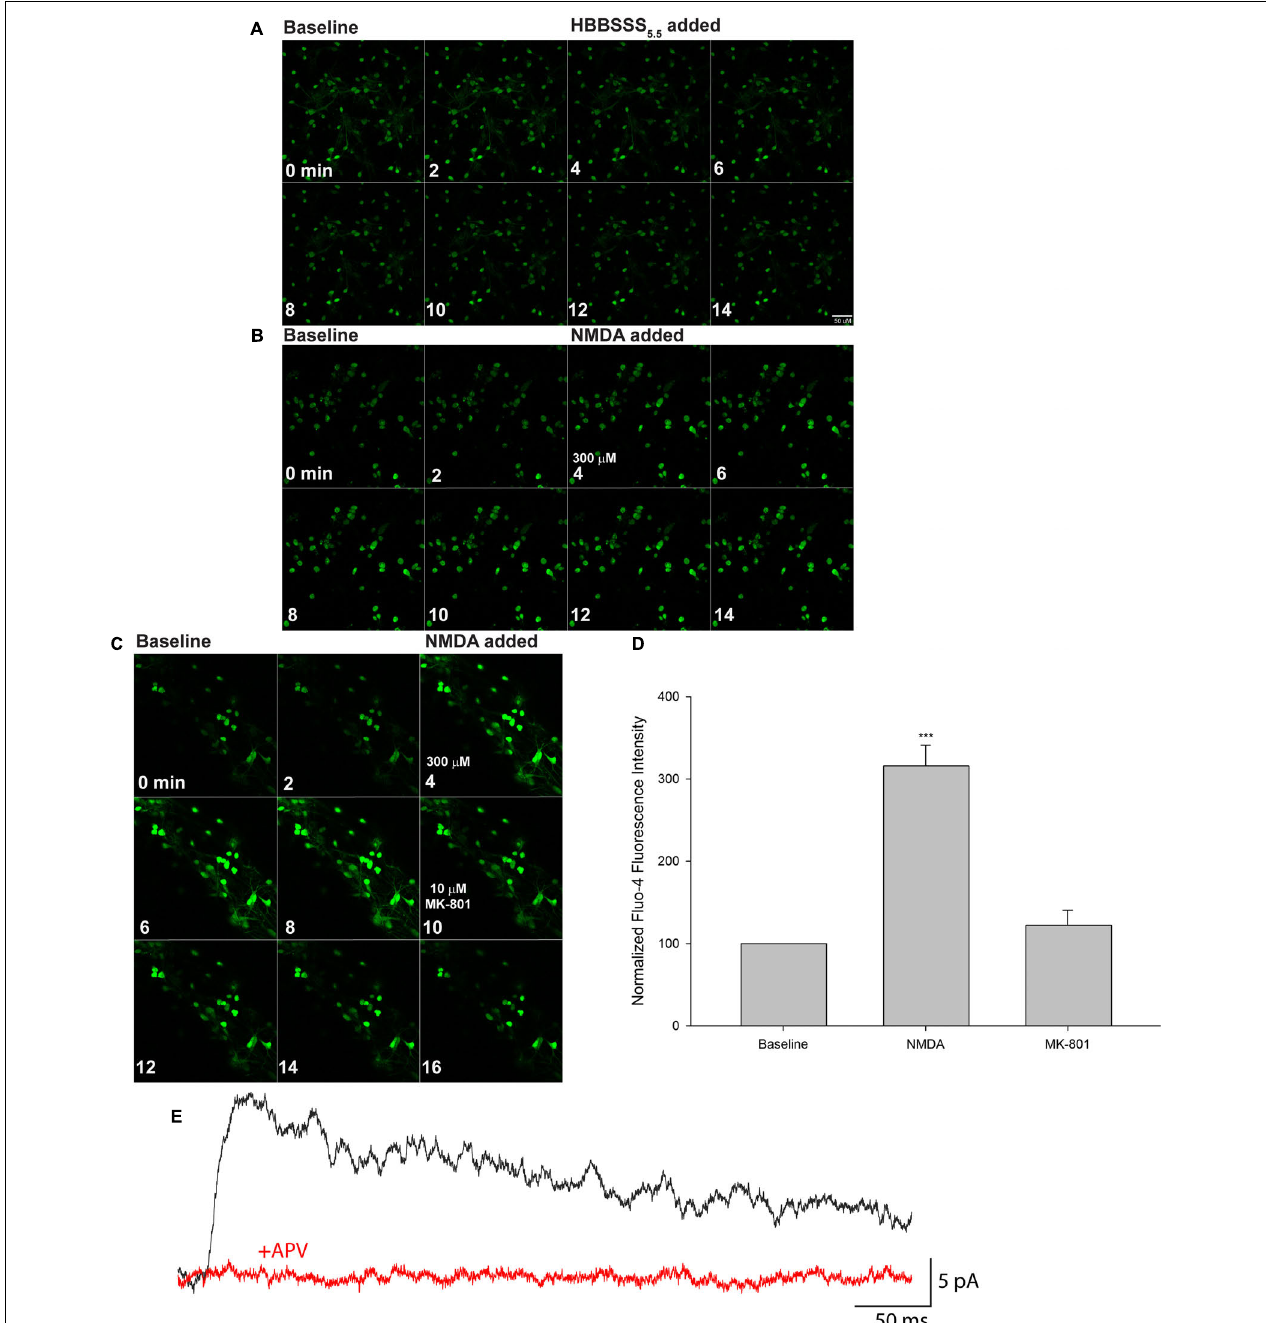
FIGURE 4 | Mature iPSC-derived neuronal cultures express functional NMDA receptors (NMDARs). XCL-4 derived mature cultures (30–39 days in maturation media) were loaded with the calcium indicator Fluo-4 for 30 min and then washed with HBBSS 5 . 5 media, followed by the addition of glycine (final concentration of 100 µ M) prior to imaging. Using a time series protocol at 40 × magnification, two baseline images were taken prior to the addition of vehicle (HBBSS 5 . 5 ), or a final concentration of 300 µ M NMDA. For some cultures, the NMDAR antagonist MK-801 at a final concentration of 10 µ M was added after additional images were taken. (A–C) Representative montages are shown. Fluo-4 time series images were analyzed using MetaMorph. Individual cells were identified and Fluo-4 fluorescence intensity at each time point was measured. The intensity of cells at each time point were averaged together. The first two time points were averaged as the baseline intensity, and all data were normalized to the corresponding baseline. (D) Data from the montage shown in panel (C) were graphed using SigmaPlot 14.5. One-way repeated measures ANOVA and Bonferroni tests were performed using SigmaPlot 14.5. Data are represented as mean + SEM. *** P < 0.001. n = 21 cells per condition. (E) A representative trace is shown of an NMDAR-mediated electrically evoked postsynaptic current from XCL-4 derived mature cells in the presence of the GABA A receptor antagonist, picrotoxin (final concentration: 50 µ M), and the AMPA receptor antagonist, NBQX (final concentration: 5 µ M), before (black) and after (red) application of the NMDAR antagonist, APV (final concentration: 50 µ M).